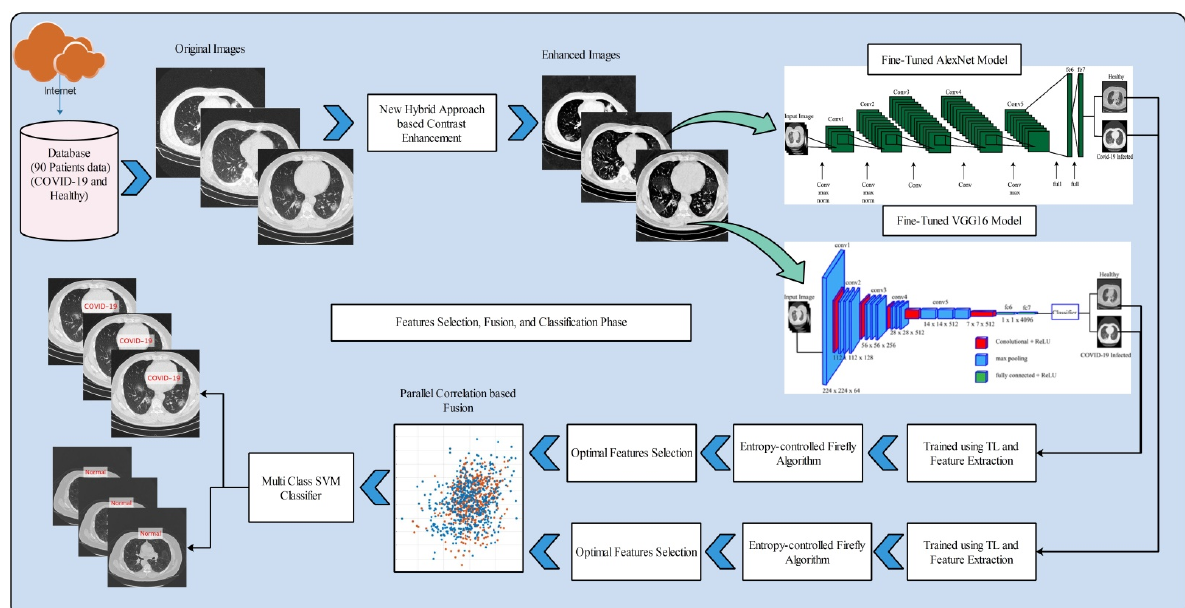
Figure 1. Proposed architecture of X-ray image classification framework using deep learning feature fusion for COVID-19 case recognition.